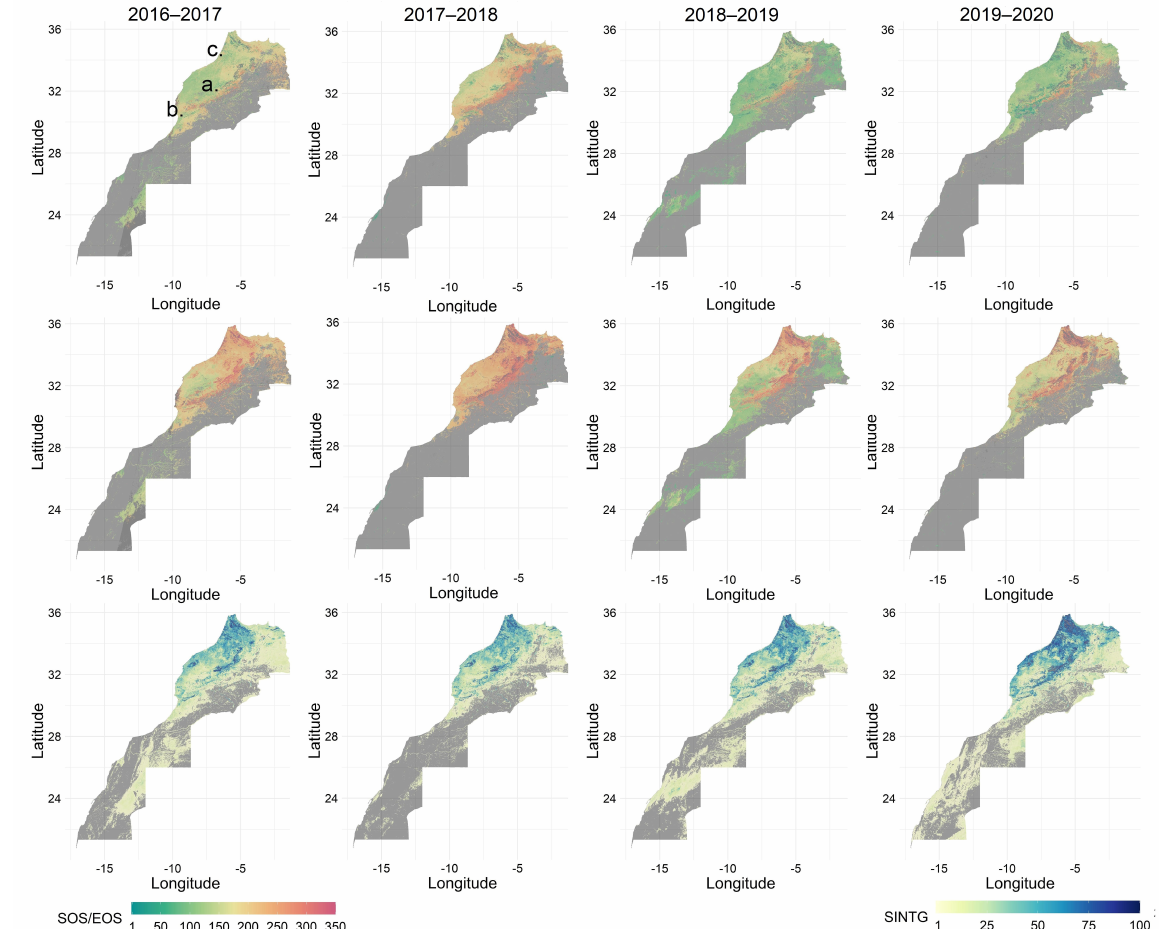
Figure 7. Example phenological metric maps for the four growing seasons (2016–2020) across Morocco. The first row is equivalent to SOS50, the MidGreenup. The second row is equivalent to EOS50, the MidGreendown. The third row is equivalent to SINTG, the small integral of the EVI2 curve, which illustrates the measure of the vegetation production within a growing season. Areas, where no SOS, EOS, or SINTG could be estimated, are shown in grey. The DOY (Day of Year) of SOS and EOS begins on the 1 September of each year. Zoom-ins for a, b, and c in are shown in Figure